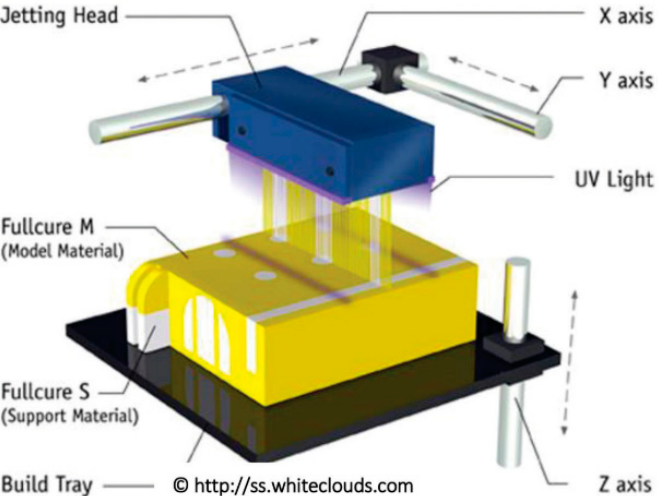
Figure 12. Digital light processing (DLP) process (adapted with permission from reference [39]).